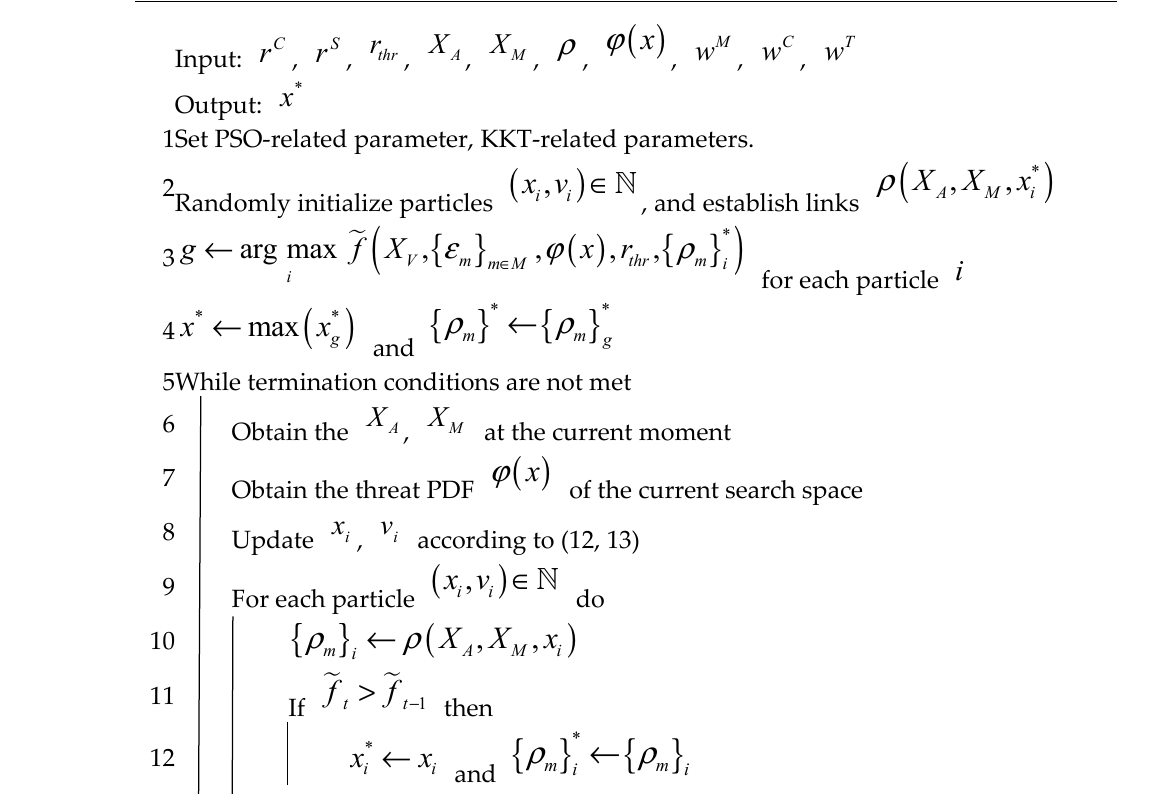
Algorithm 1. Threat Avoidance and Reconnaissance FANET Construction Algorithm 1 Threat Avoidance and Reconnaissance FANET